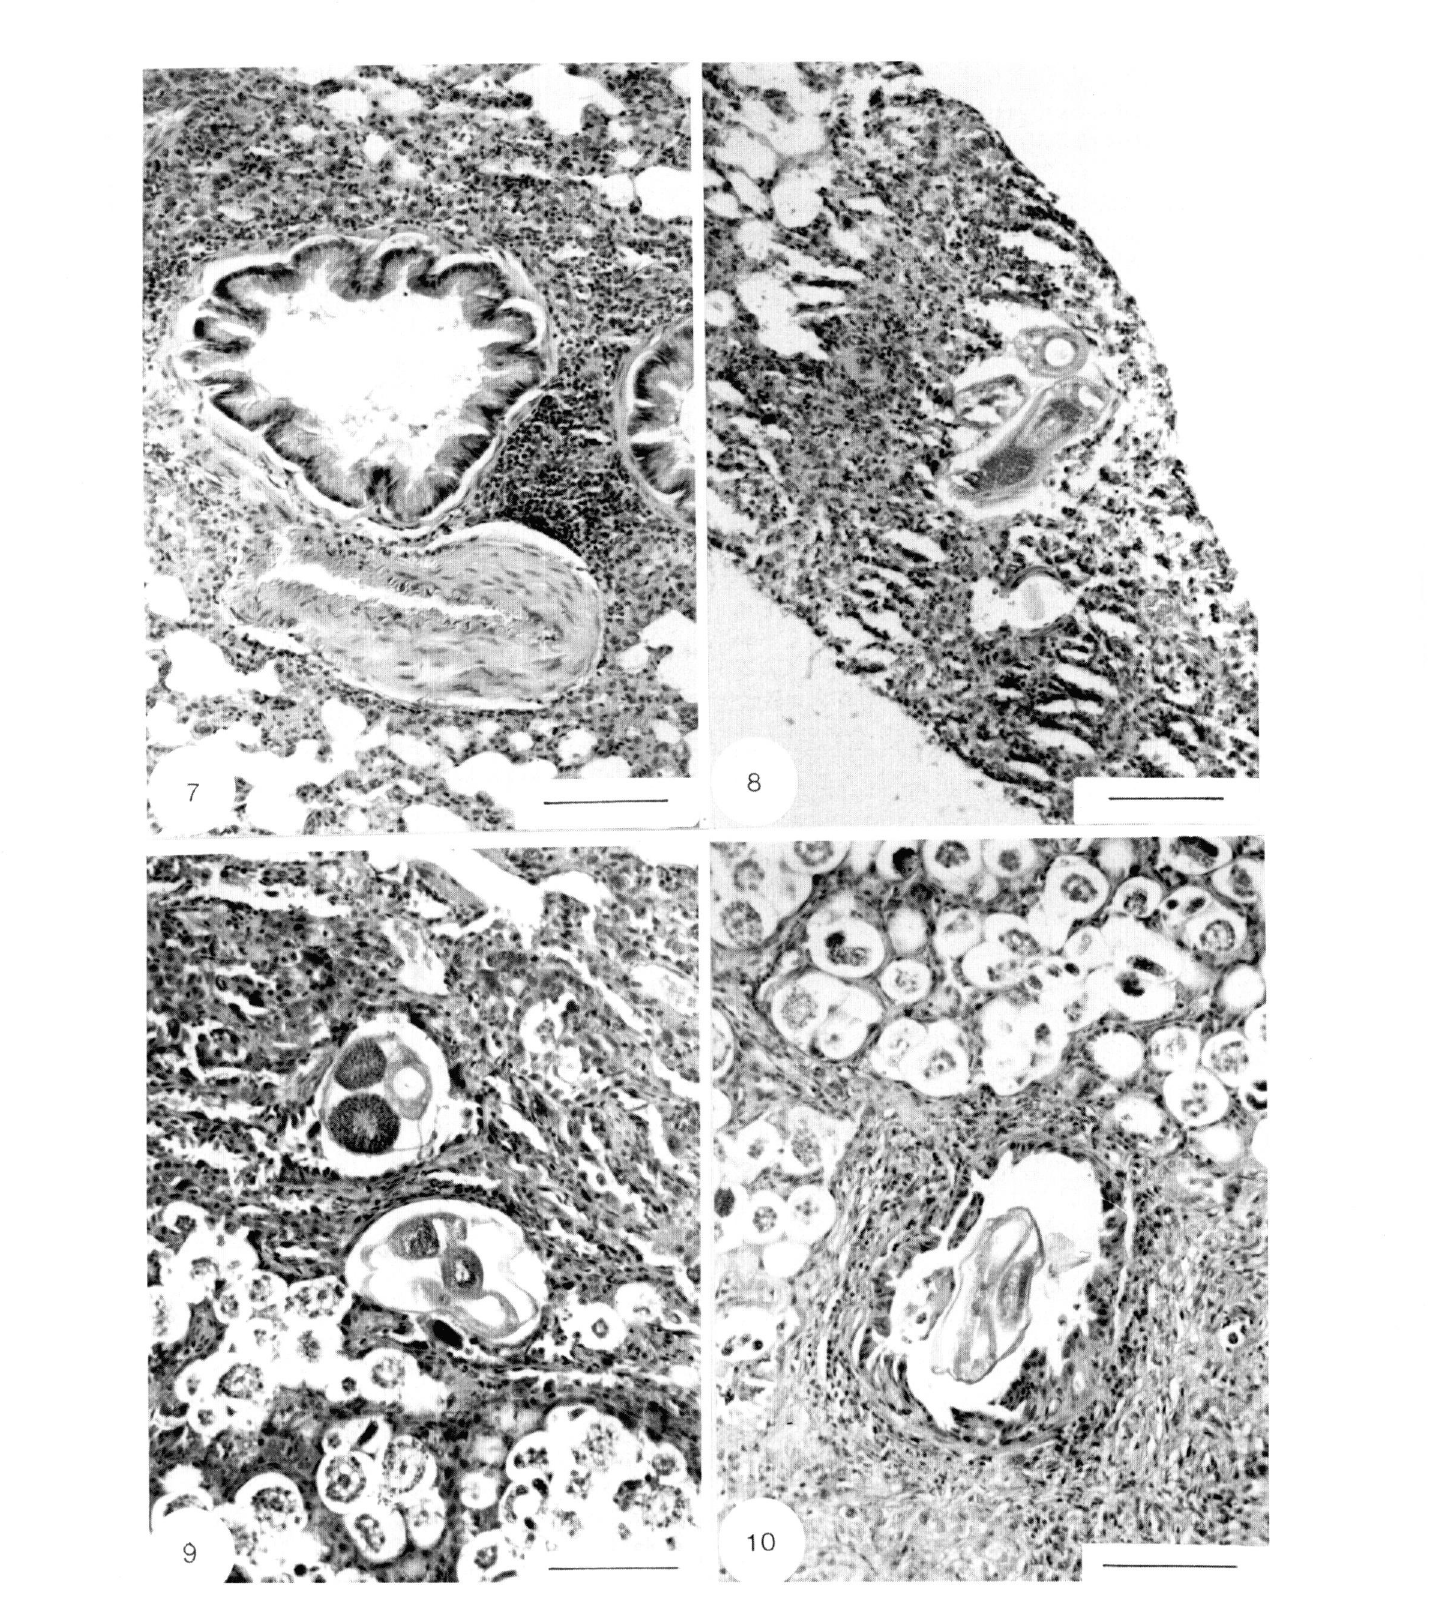
Figs 7-10. - Pathological changes in the lungs during experimental infection of Gallegostrongylus australis in Rattus fuscipes. 7. Infiltra­ tions of neutrophils around bronchus and pulmonary artery 20 DAI, bar = 100 um. 8. Bronchiolitis in respiratory bronchioles containing subadult nematodes and infiltrations of neutrophils in surrounding pulmonary parenchyma 20 DAI, bar = 100 um. 9. Adult nematode and embryonated eggs surrounded by numerous neutrophils, eosinophils and foamy macrophages 42 DAI, bar = 100 um. 10. Adult nematode in bronchiole, peri-bronchiolar cuffing of neutrophils and developing fibrosis in interstitium 78 DAI, bar = 100 um. 122 Mémoire